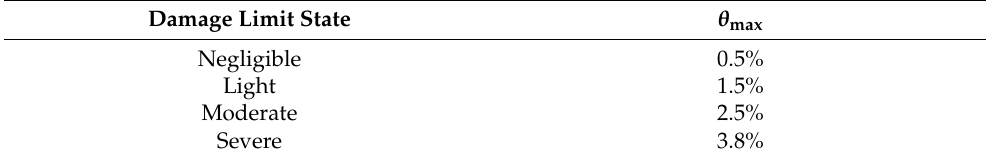
Table 5. Criteria for four damage limit states.